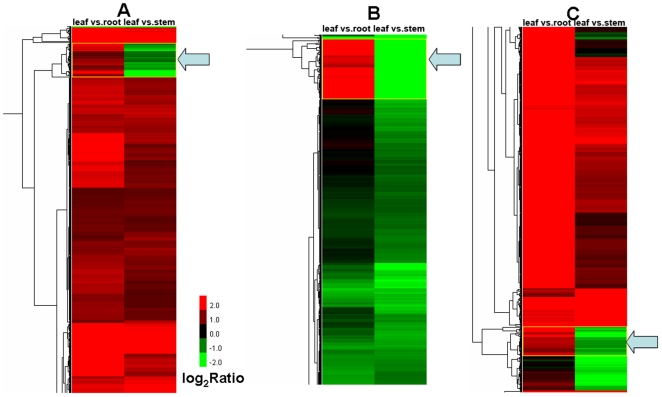
Clusters containing the taxane biosynthetic genes detected in the clustering analyses of DEGs.Each column represents a pair of tissues used in comparison, while each row represents a gene. Expression differences are shown in different colors. Red means up-regulated and green means down-regulated. A, a cluster of 29 Unigenes found in the clustering analysis of the intersection of DEGs (indicated by an arrowhead); B, a cluster of 51 Unigenes found in the analysis of the union of DEGs (indicated by an arrowhead); C, a cluster of 25 Unigenes found in the analysis of the union of DEGs (indicated by an arrowhead).